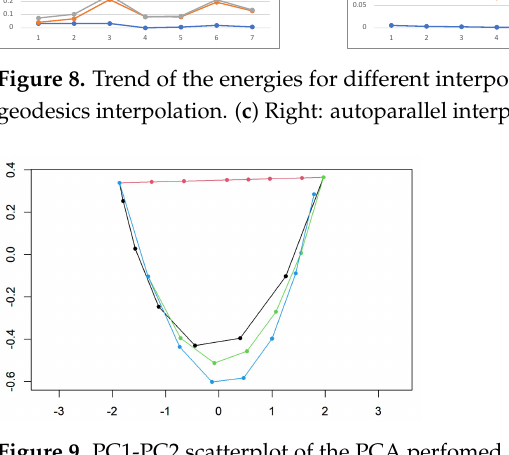
Figure 9. PC1-PC2 scatterplot of the PCA perfomed on the four set of shapes resulting from the pure bending case. PC1 explains 91.11% of total variance, while PC2 explains 6.50%. Black refers to the optimized shapes, red to the linearized, green to the original shapes and cyan to the shooted